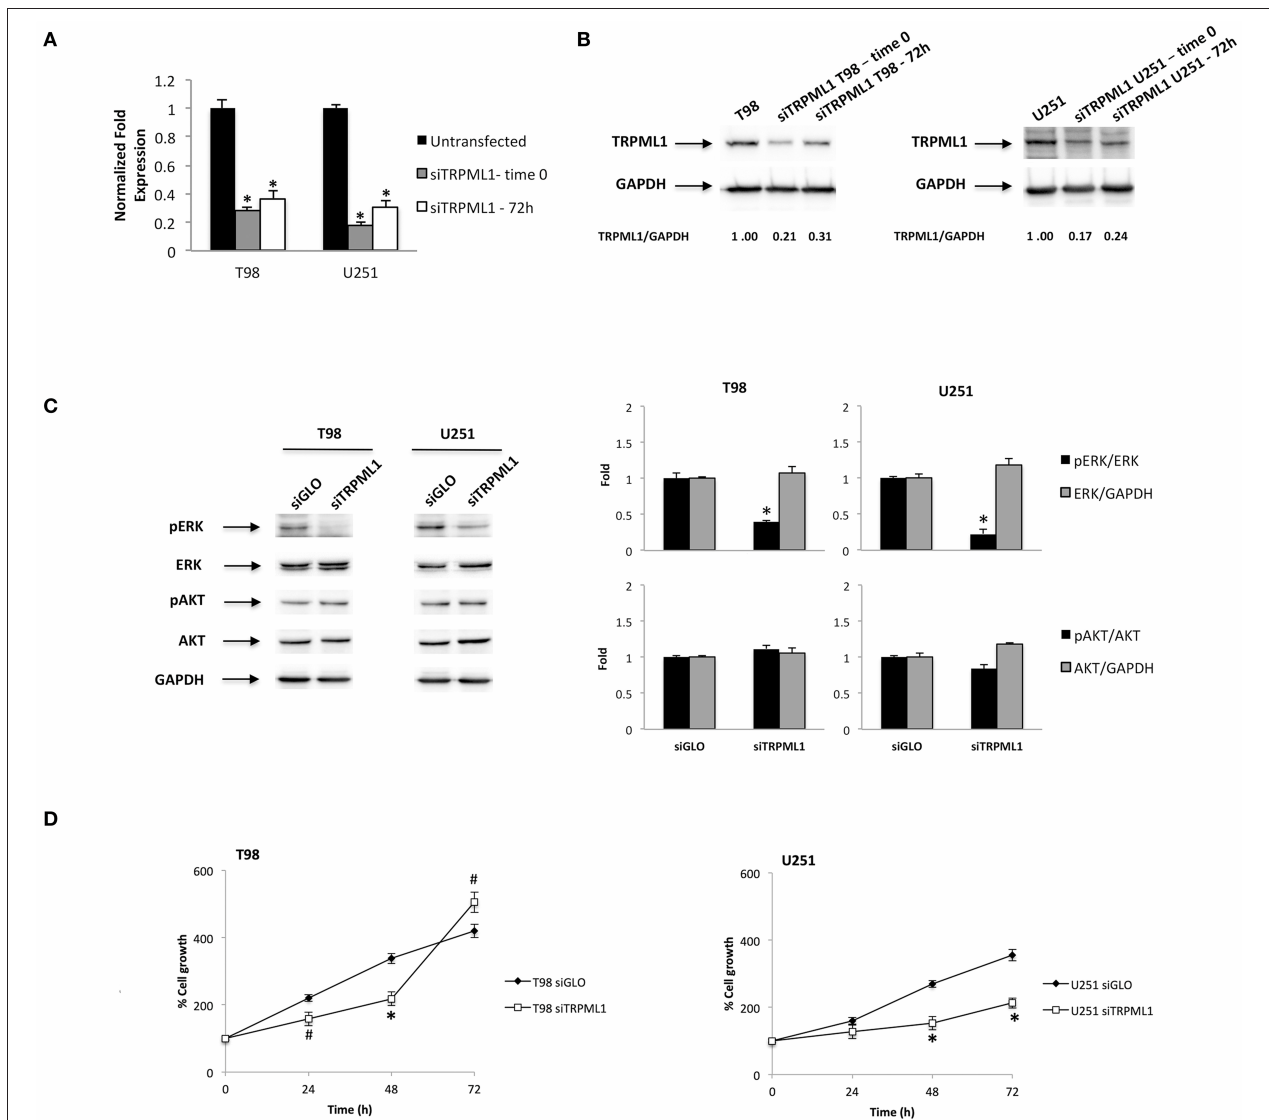
FIGURE 1 | Transient receptor potential mucolipin 1 (TRPML1) silencing affects glioblastoma cell viability. (A) The relative TRPML1 mRNA expression in untransfected and siTRPML1 T98 and U251 glioma cell lines after 72h of silencing (time 0) and after 72-h post-transfection was evaluated by the quantitative reverse transcription (qRT)-PCR. TRPML1 mRNA levels were normalized for glyceraldehyde-3-phosphate dehydrogenase (GAPDH) expression. Data are expressed as mean ± SD; * p < 0.001 vs. untransfected. (B) The Western blot analysis of TRPML1 protein levels. Blots are representative of one of three separate experiments. TRPML1 densitometry values were normalized to GAPDH used as loading control. The TRPML1 protein levels of silenced samples were determined with respect to TRPML1 levels of untransfected cells. (C) The Western blot analysis of pERK, ERK, pAKT, and AKT protein levels in siGLO and siTRPML1 T98 and U251 cells after 72h of silencing (time 0). Blots are representative of one of three separate experiments. ERK and AKT densitometry values were normalized to GAPDH used as loading control. The pERK and pAKT protein levels were determined with respect to ERK and AKT levels. * p < 0.01 siTRPML1 vs. siGLO. (D) Cell viability was evaluated by 3-(4,5-dimethylthiazol-2-yl)-2,5-diphenyltetrazolium bromide (MTT) assay in siGLO control and in siTRPML1 T98 and U251 glioblastoma cells for up to 72h. Data shown are expressed as mean ± SE of three separate experiments. * p < 0.01 and # p < 0.05 siTRPML1 vs. siGLO.